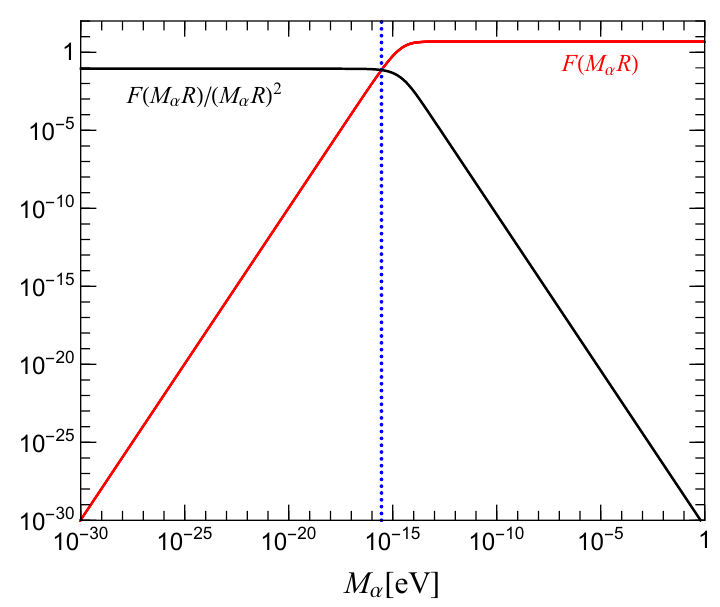
Figure 1 . Dependence of the factors F ( M (cid:11) R ) and F ( M (cid:11) R ) = ( M (cid:11) R ) 2 on the scalar mass M (cid:11) for the sun, from eq. (2.9), choosing n 0 = 10 11 eV 3 . We take R = 6 : 955 (cid:2) 10 5 Km and n e ( r ) from e refs. [14, 15]. The vertical blue dotted line denotes M (cid:11) = 1 =R ’ 2 : 84 (cid:2) 10 (cid:0) 16